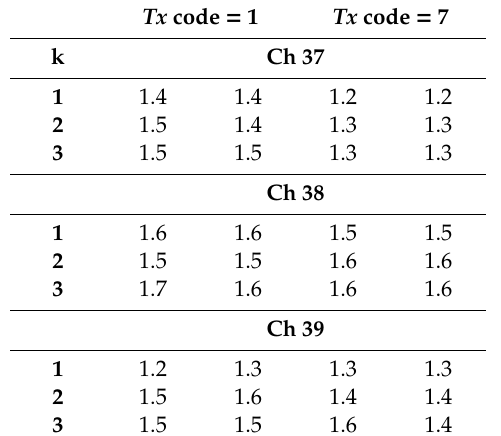
Table 8. Accuracy (in m) for Test #2a. For each Tx code, the first and second data columns refer to the iBeacon and Eddystone protocol respectively. The three advertising channels are referred to as Ch 37, etc., and the number of neighbors in the WKNN algorithm, as k